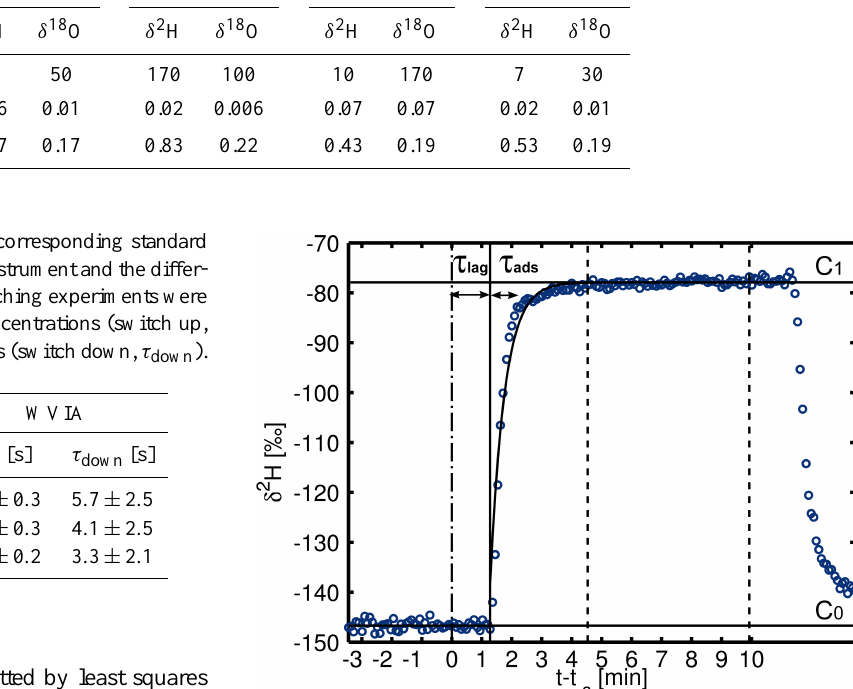
Table 6. Key characteristics of the short-term stability of laser spectroscopic isotope measurements. σ A is the Allan deviation. τ 0 is the optimal integration time. Instrument L1115-i L2130-i